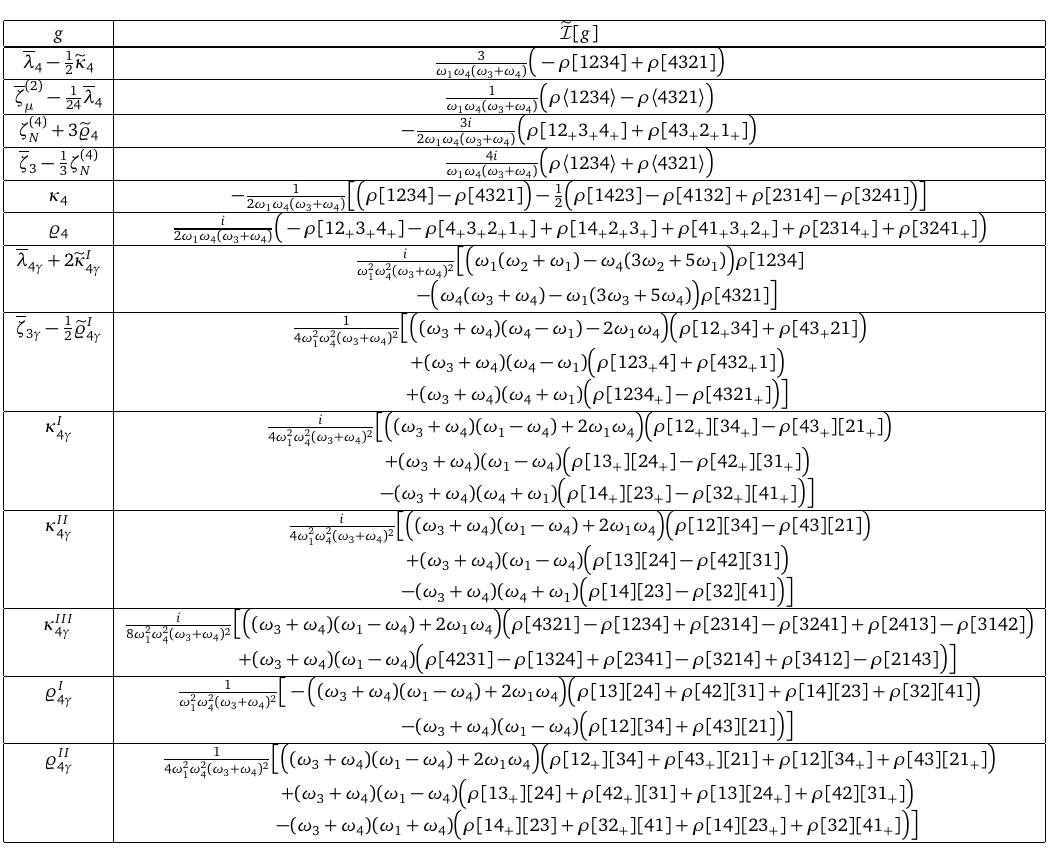
Table 2: Couplings with even parity under time-reversal